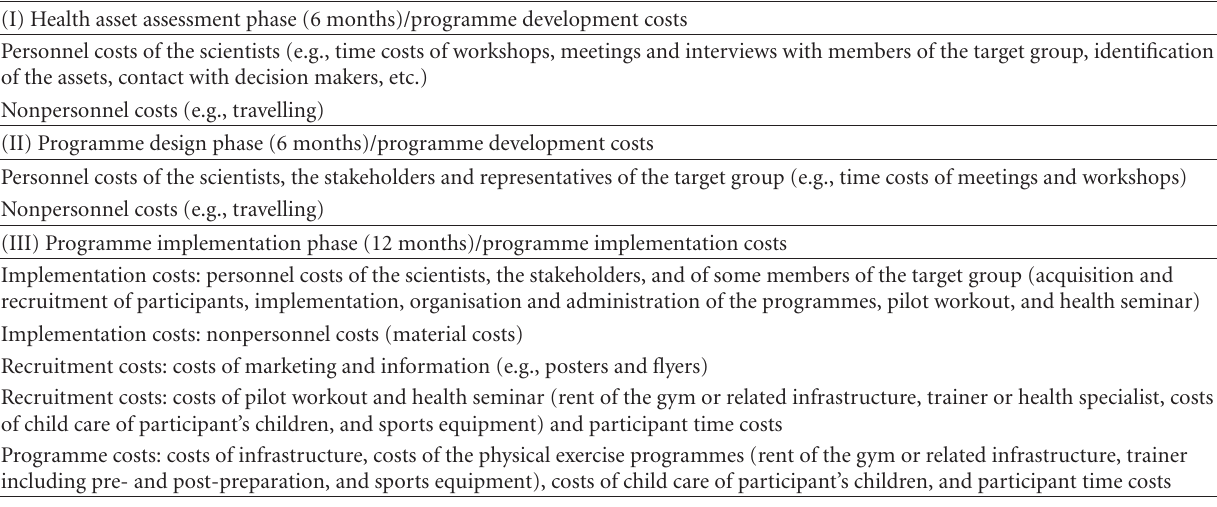
Table 1: Input-oriented subdivision of costs by project phases.